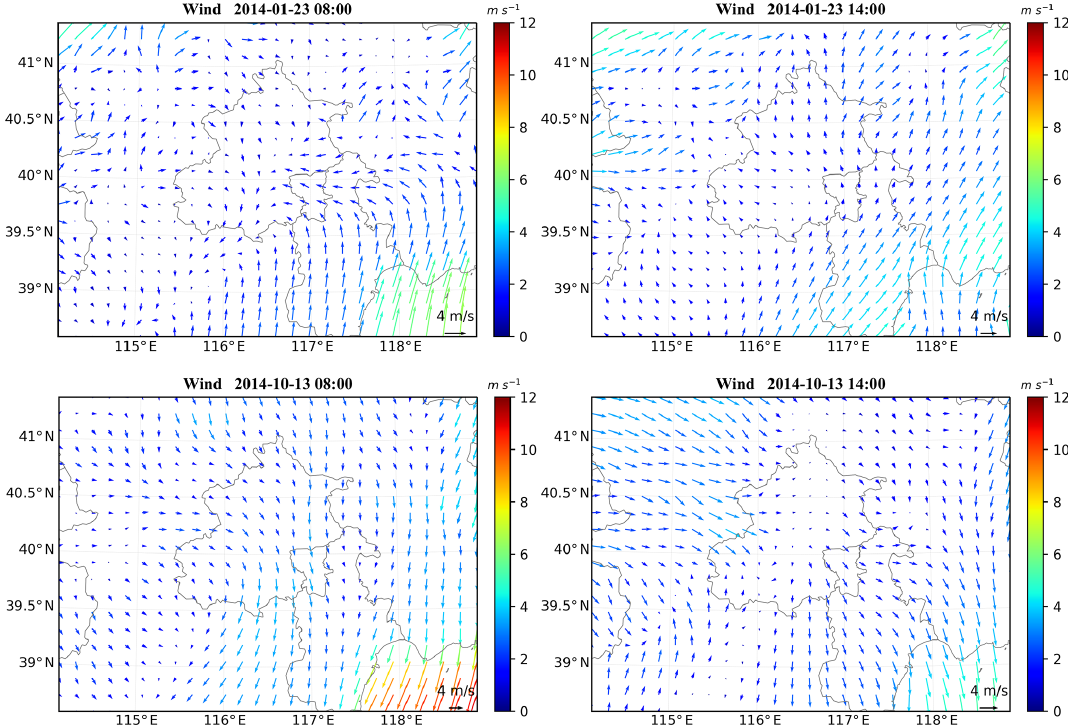
Figure 7. Wind fields in Beijing and the surrounding area from the ECWRF at 08:00 (left column) and 14:00 (right column) BJT on 23 January and 13 October